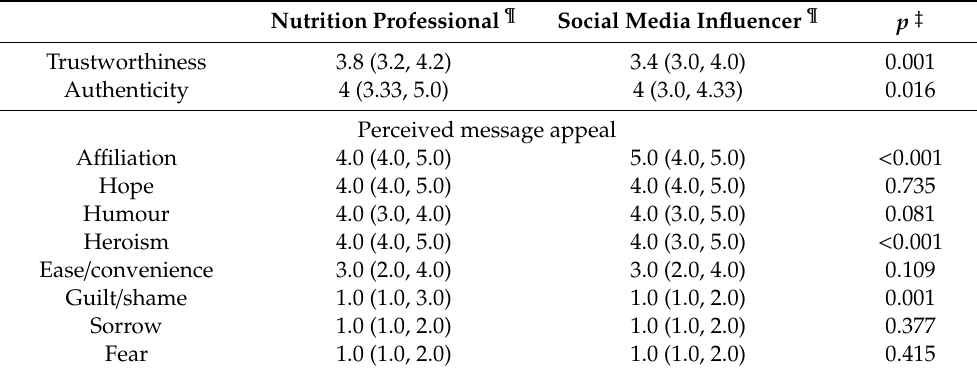
Table 3. Descriptive statistics for scales used in the questionnaire to assess perceptions of the nutrition professional or social media influencers post; trustworthiness of post content, authenticity of